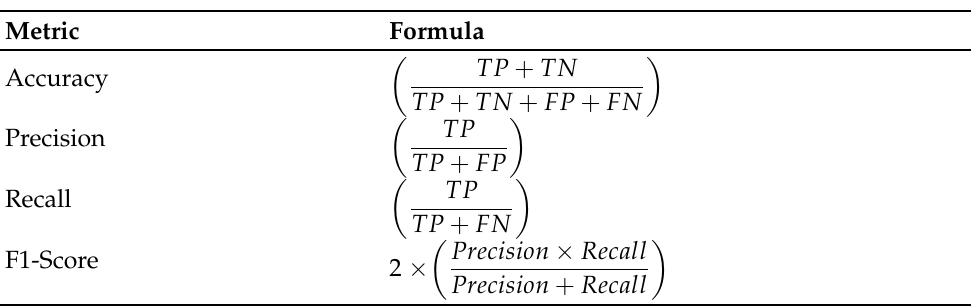
Table 7. Evaluation metrics for binary